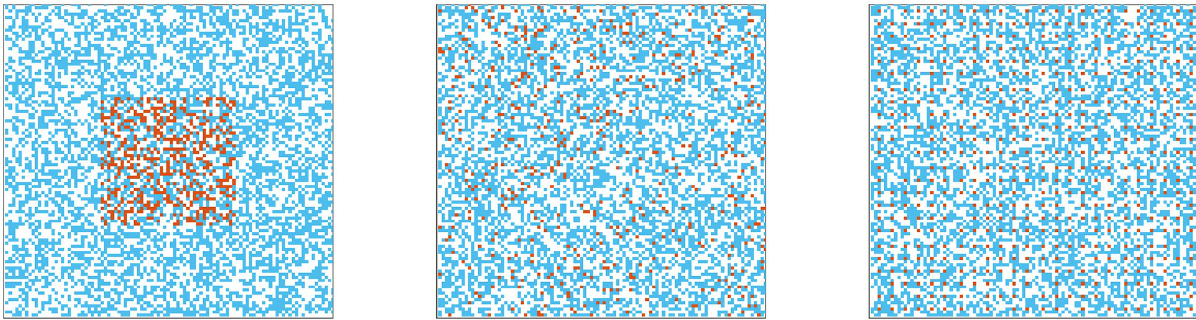
Fig 1. Initial cell configurations. Three types of initial cell configurations. Orange dots: R-cells, blue dots: S-cells, white dots: empty sites. Clumped R cells (first), random R-cells (center), and uniform R-cells (right).